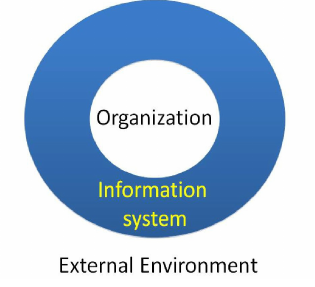
Figure 4. Information systems interfaces